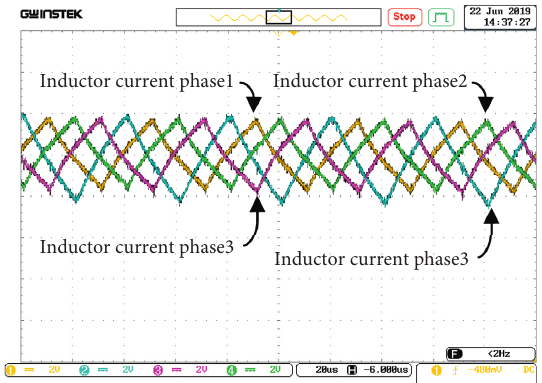
Figure 15: Result of the four-phase interleaved boost converter circuit at voltage of 20V without the controller.